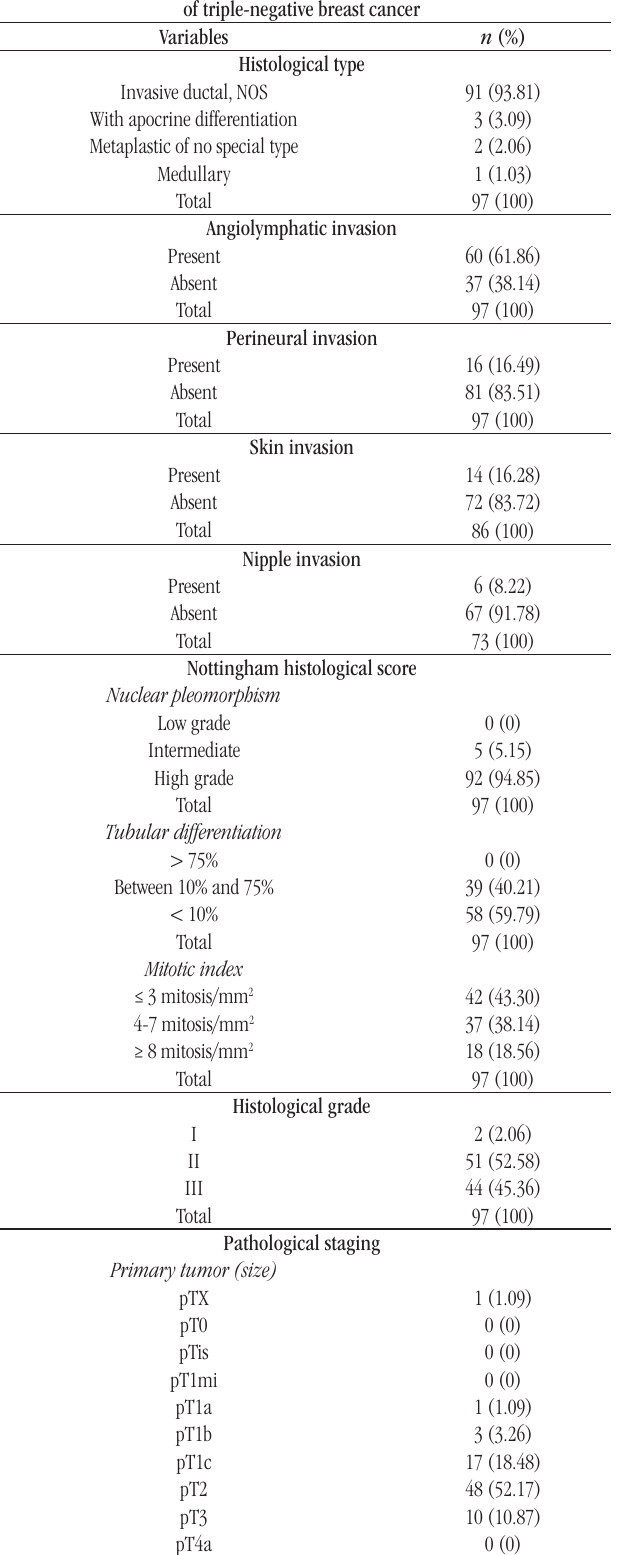
taBLE 2 − Histomorphological characteristics of triple-negative breast cancer